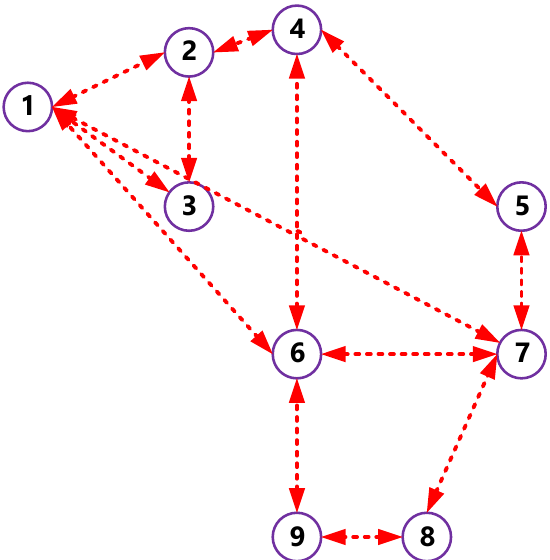
Figure 6. The information exchange graph among the connected agents.